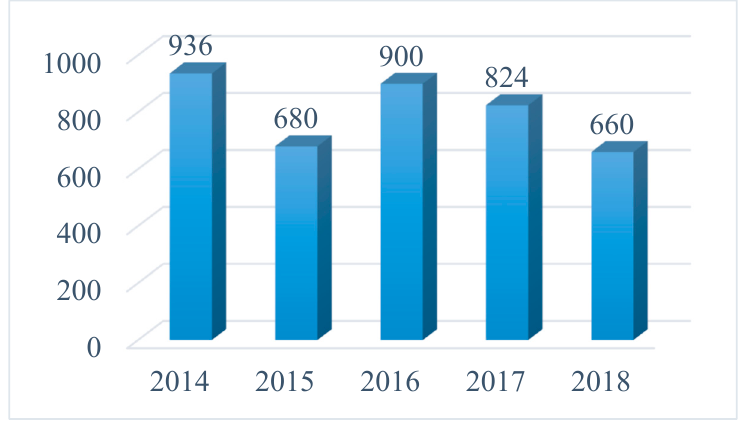
Figure 1. Agricultural profit in the Czech Republic (EUR millions) [27].